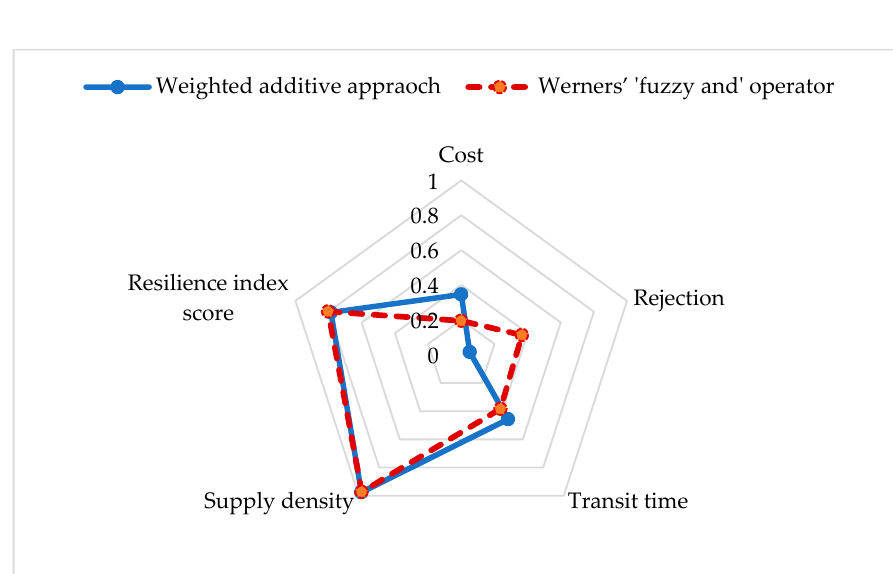
Figure 2 . Achievement levels of objectives Figure 2. Achievement levels of